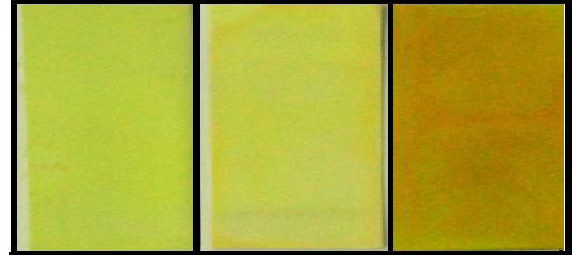
Figure 29: Photographs of test strips of R 34 towards various concentrations of acetate (ref.